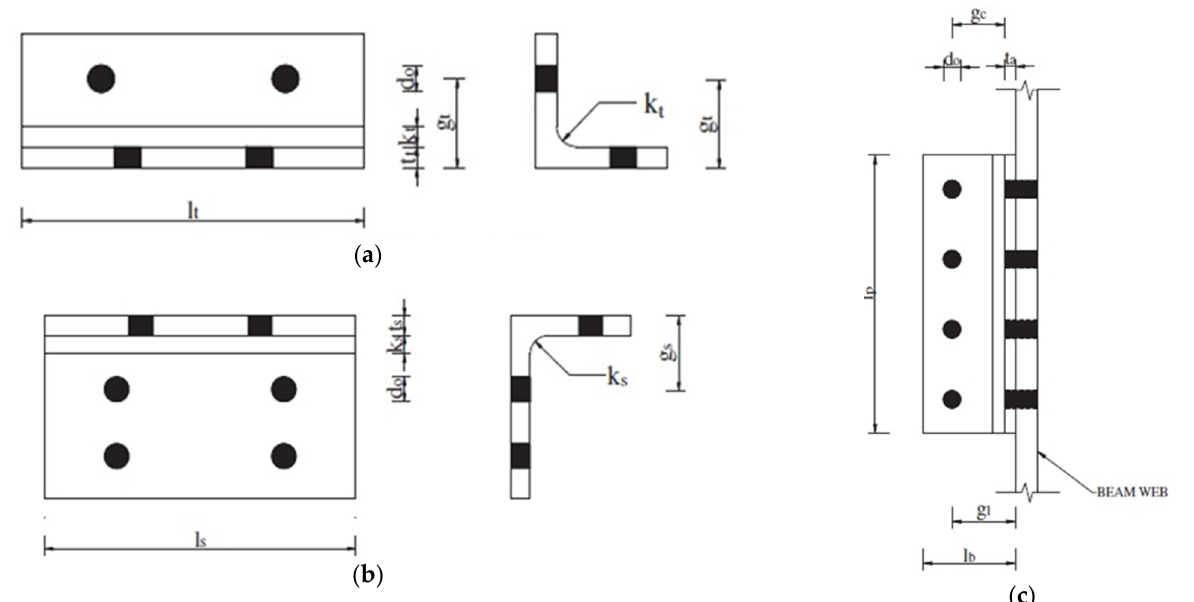
Figure 5. Geometrical parameters of the reference TSACW: ( a ) top angle, ( b ) seat angle, ( c ) web angle. Reproduced from [14] with permission from Elsevier, copyright agreement with license number 5011231057466, February 2021.